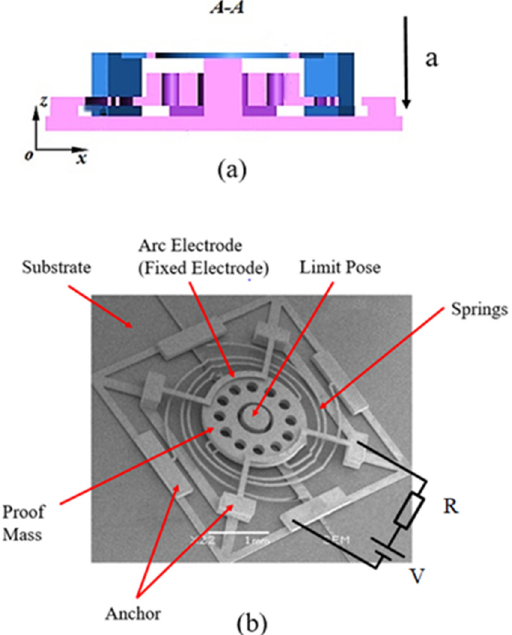
Figure 4. The contact-enhance inertial switch (Du et al. 2020 [8]): ( a ) the cross section of the switch model; ( b ) the SEM image of the switches.